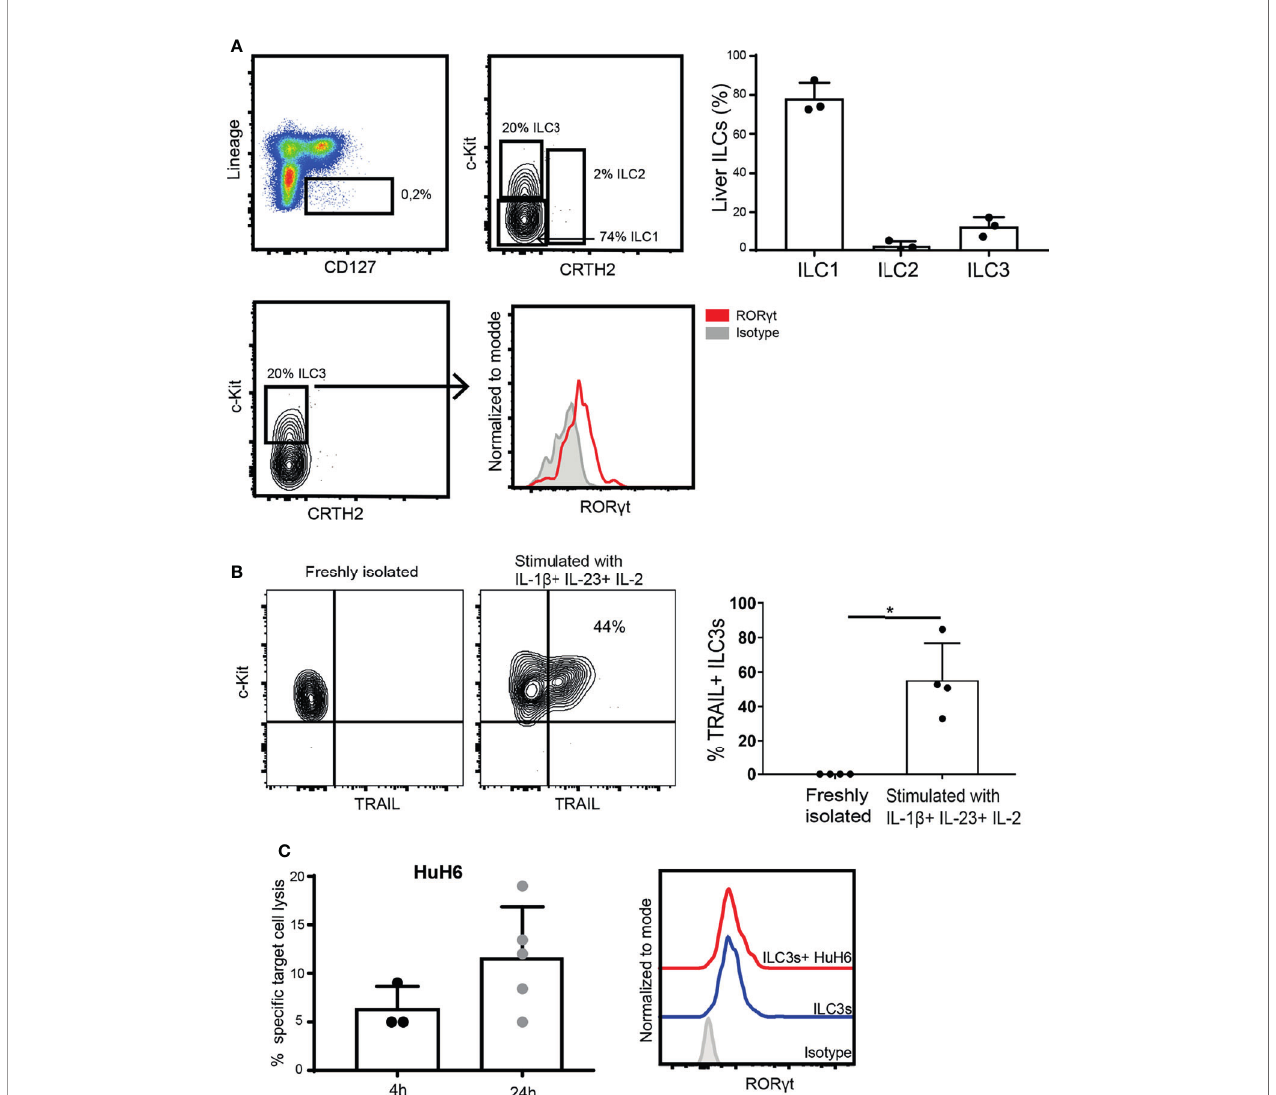
FIGURE 5 | Intra-hepatic ILC3s are able to kill hepatic tumor cells. (A) Representative analysis of liver ILCs, gated as live CD45 + , Lineage - (CD3 - , CD19 - , CD14 - , CD34 - , CD94 - , CD123 - , TCR a / b - , TCR g / d - , FC ϵ R1 a - ), CD127 + cells. ILC1s were de fi ned as c-Kit - CRTH2 - ; ILC2s as c-Kit + CRTH2 + ; and ILC3s as c-Kit + CRTH2 - (left). Percentage of ILC1s, ILC2s and ILC3s among CD127 + Lin - cells (n=3 liver samples from different donors, right). Representative histogram of ROR g t expression by freshly-isolated intra-hepatic ILC3s (down). (B) Representative contour plot of c-Kit and TRAIL expression (left), and frequency of TRAIL-expressing ILC3s before and after exposure to cytokines (right, n=4 liver samples from different donors, *p <0.05 by Mann-Whitney test). (C) Speci fi c target cell lysis of HuH6 cells after 4h and 24h of co-culture with cytokine-stimulated ILC3s (n=3-5 liver samples from different donors, E:T ratios 1-3:1, depending of ILC3 yield per donor). Representative histograms of ROR g t expression by intra-hepatic ILC3s after the co-culture with HuH6 cells